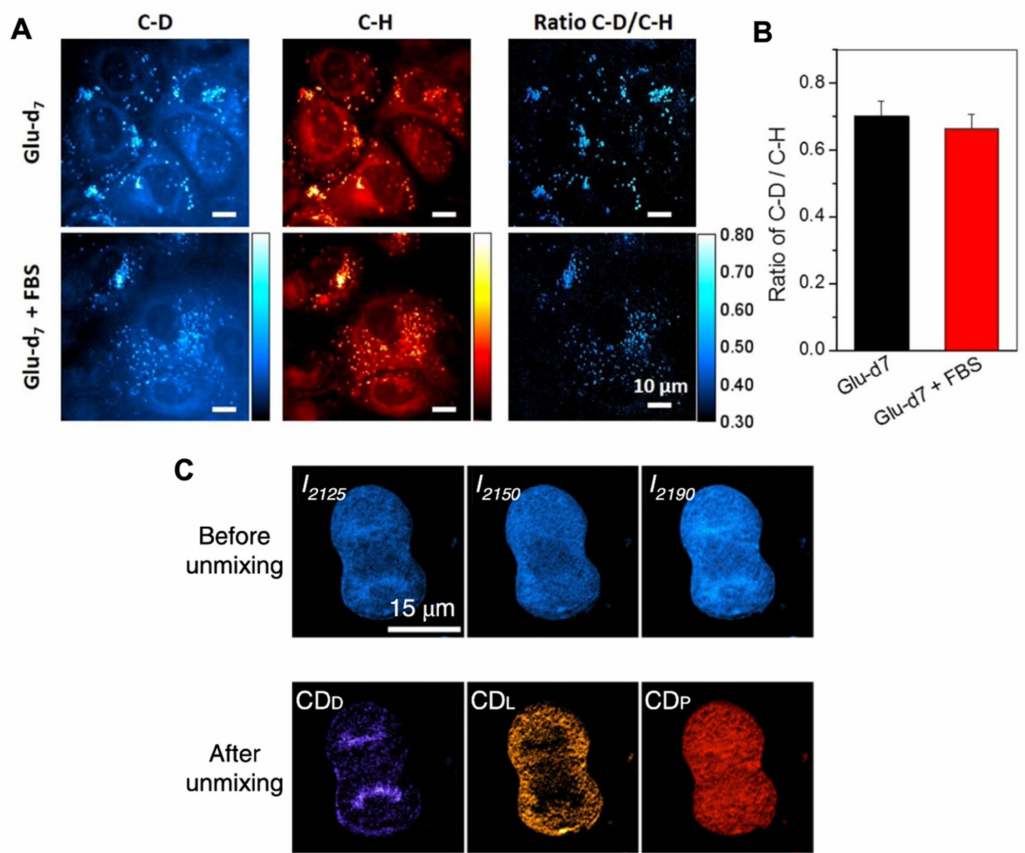
Figure 7. SRS imaging of cancer cells from deuterated glucose ( A , B ). Glucose-d 7 -incubated pancreatic cancer PANC1 cells were treated without or with 10% FBS for 3 days. SRS imaging at C–D and C–H vibration were taken and the ratio of C–D/C–H was used to analyze the level of de novo lipogenesis and increased lipogenesis. Reprinted and adapted with permission from reference [127]. ( C ) SRS images of a glucose-d7-labelled mitotic HeLa cell before and after unmixing, showing distribution of DNA, lipids, and proteins. Reprinted and adapted with permission from Reference